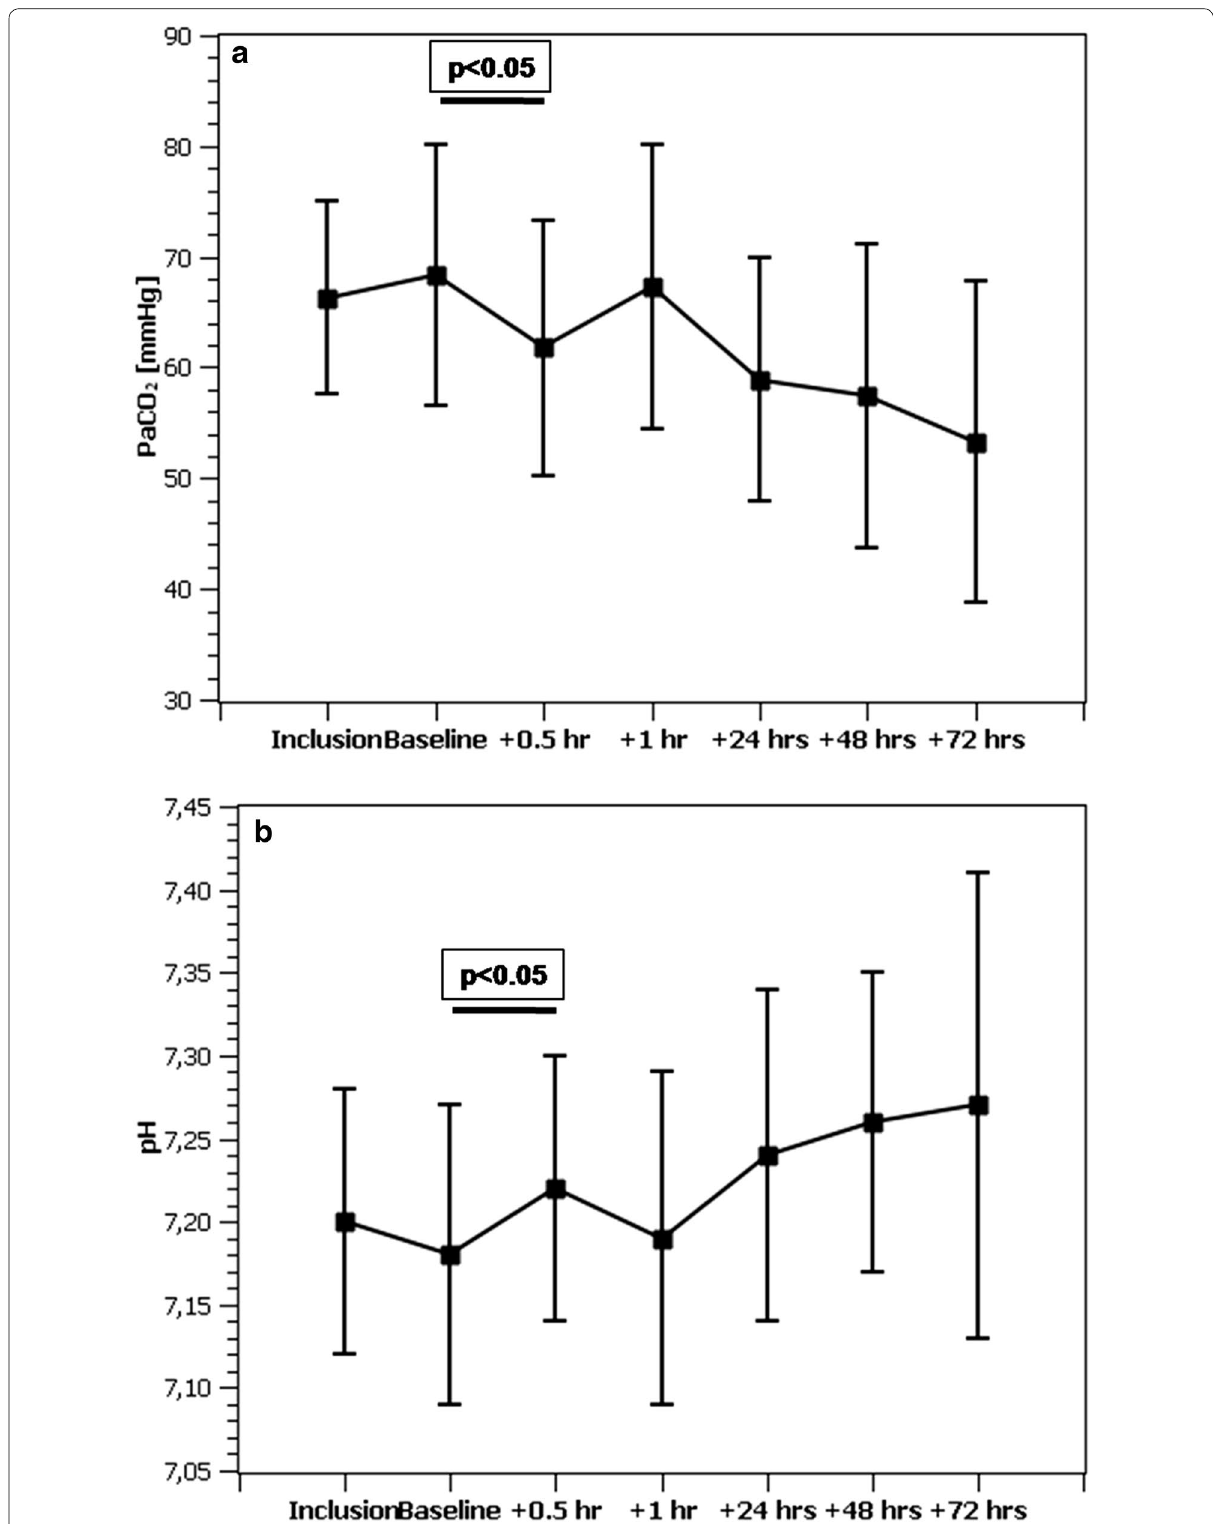
Fig. 2 Time course of a arterial CO 2 partial pressure and b pH over the study period. After adjusting ventilation parameters to reestablish baseline PaCO 2 at 1 h, a trend toward further normalization of hypercapnic acidosis was